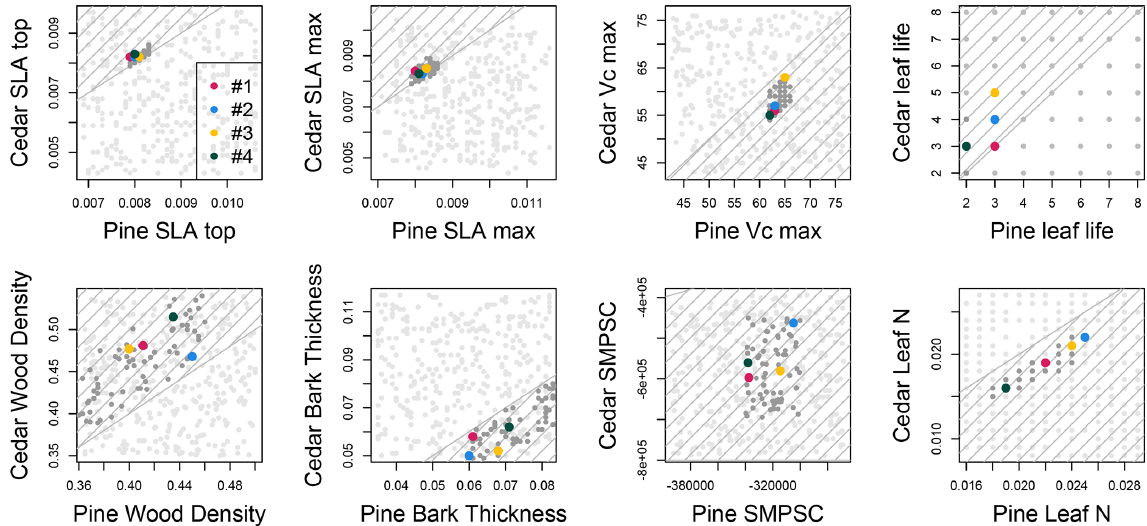
Figure 2. Distribution of pine and incense cedar parameter values in a 360-member ensemble (light gray), in which selected values were constrained by trait correlations and the distributions of observations, and in a 72-member ensemble (dark gray), in which values were additionally constrained to preserve the appropriate relative values between pine and incense cedar (hatched area). The parameterizations retained from filtering based on expectations in Table 2 are shown in